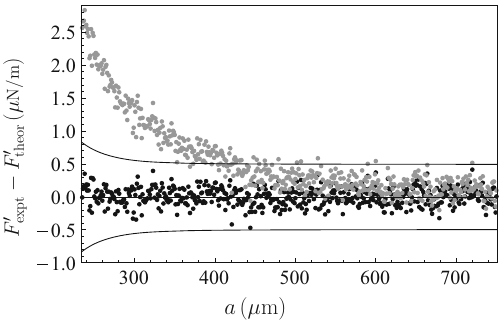
Fig. 2 The differences between experimental [14] and theoretical gra- dients of the Casimir force computed using the alternative nonlocal (black dots) and the standard Drude (grey dots) responses are shown as functions of separation. The two solid lines indicate borders of the 67% confidence